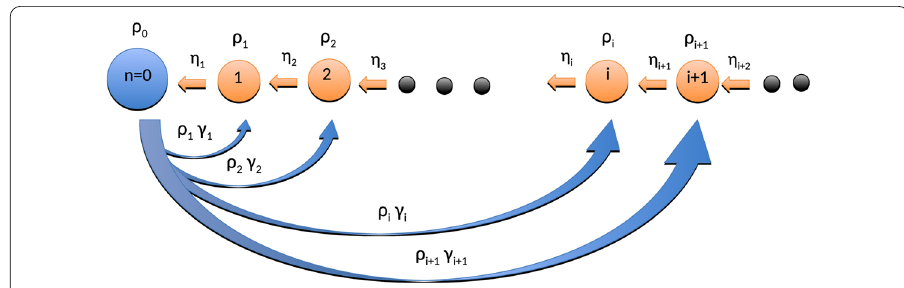
Figure 1 Dynamics for the FJM model. Sketch of the dynamics that leads in the continuum limit the master equation